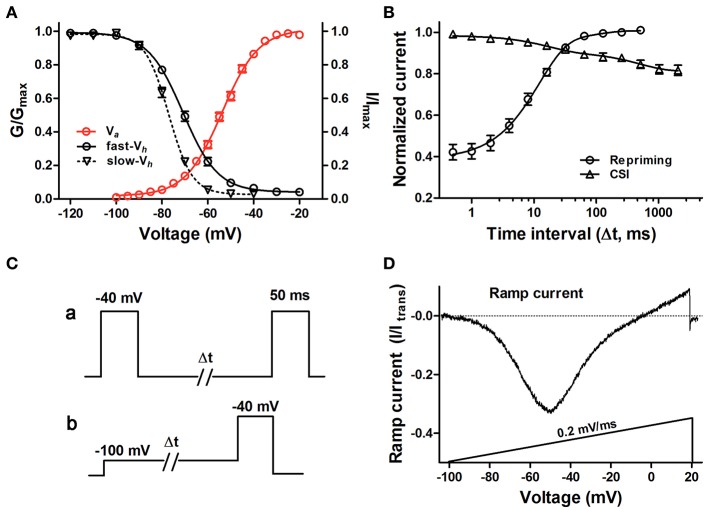
Biophysical properties of hNav1.9-GFP in ND7/23 cells. (A) Voltage-dependent activation, steady-state fast-inactivation and slow-inactivation of hNav1.9-GFP. Data points for activation and inactivation kinetics were well fitted with the Boltzmann equation. (B) Time course of recovery from fast inactivation and development of close-stated inactivation of hNav1.9-GFP. Lines represent data fitted with a one-exponential function. (C) Protocols for the recovery from fast inactivation (a) and the development of CSI (b). To determine the recovery from fast inactivation, a 50-ms prepulse at −40 mV was used to move channels into the fast inactivated state, followed by a pulse at −120 mV with increased duration to allow channels to recover from fast inactivation before a 50-ms test pulse at −40 mV to measure the available current. To determine the development of CSI, from a holding potential of −120 mV, the cells were prepulsed to −100 mV (pre-open state) for increasing durations before a 50-ms test pulse to −40 mV. The repetition interval was 10-s. (D) Representative ramp currents of hNav1.9-GFP in response to slow depolarization (0.2 mV/ms) were normalized to the transient peak current and plotted as a function of membrane potentials. Data points are represented as mean ± S.E.M. One micro molar TTX were applied in all experiments.